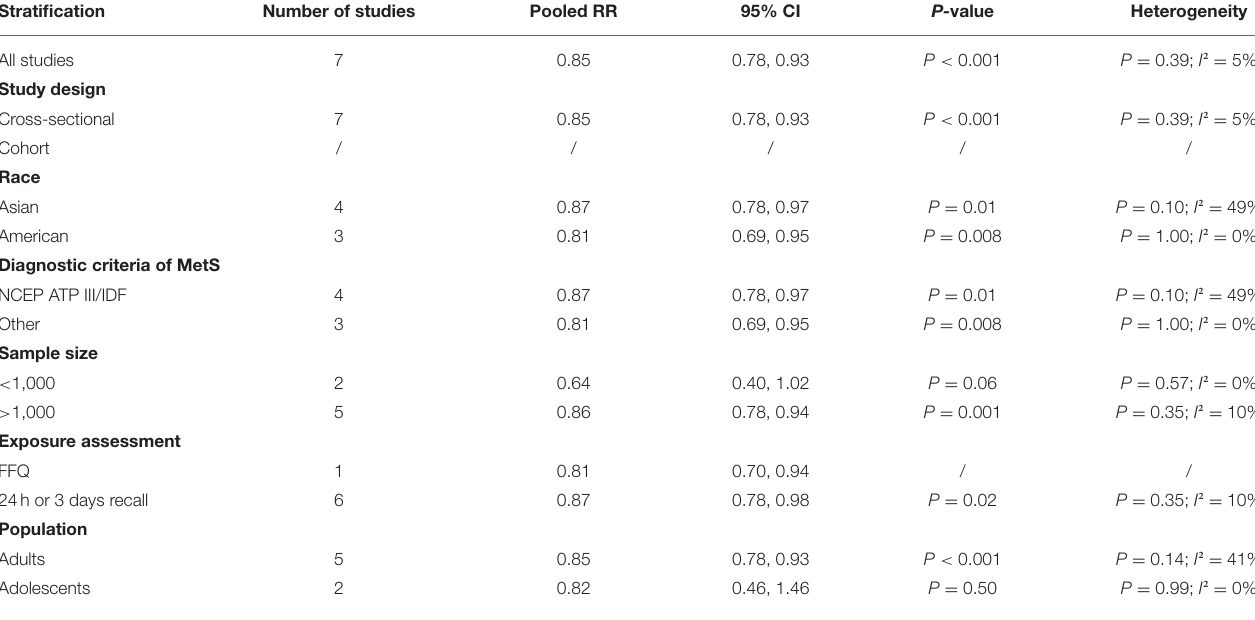
TABLE 3 | Subgroup analysis of MetS for the highest vs. lowest dietary copper level